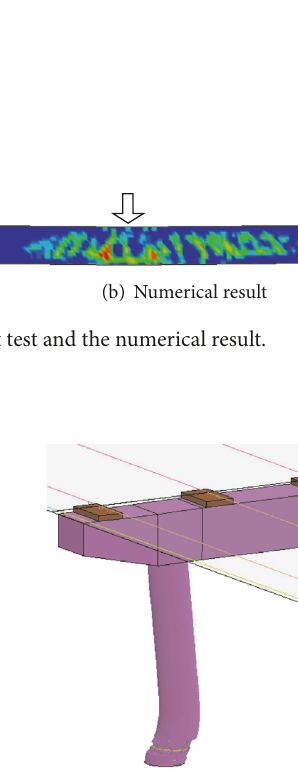
Figure 12: Failure mode of the pier of numerical